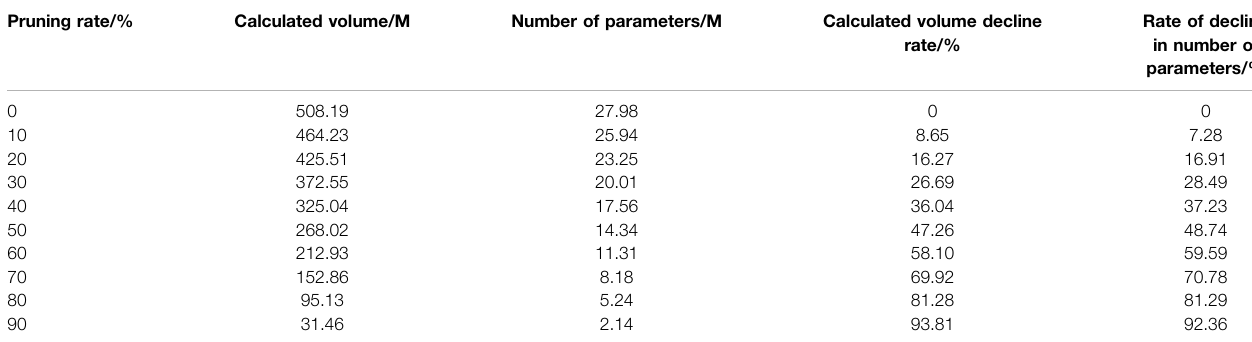
Rate of decline rate/% in number